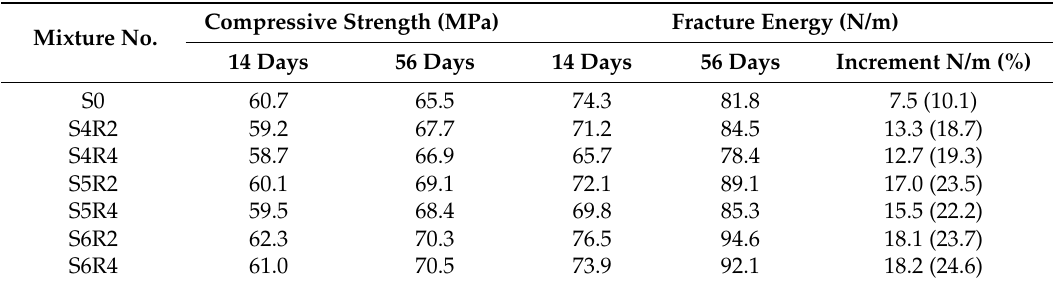
Table 4. Fracture energy of the concrete.